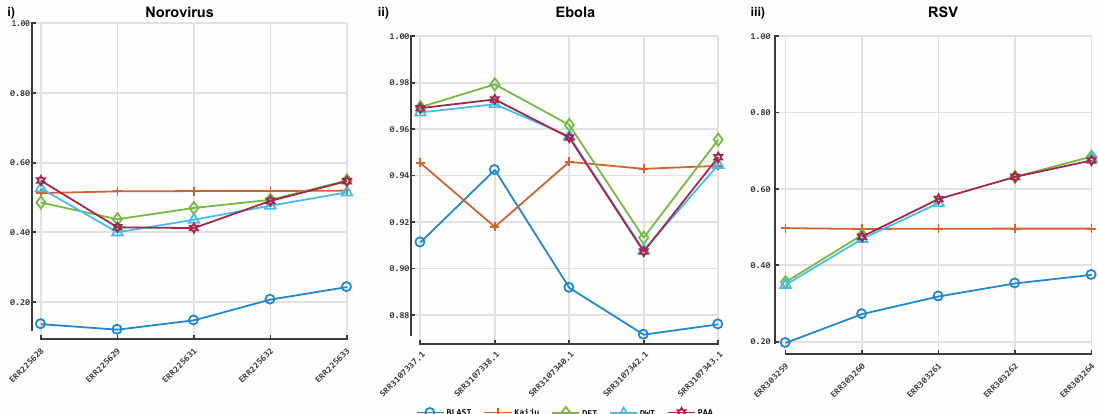
Figure 5. Accuracy of our prototype classification implementation and two established tools on real sequences. The y -axis indicates the F -measure score, and the x -axis depicts the reads data files. Plot 5-i depicts the F -measures obtained for each classifier on the Norovirus sequences data. Plot 5-ii illustrates the F -measures obtained for each classifier on the Ebola sequence data. Plot 5-iii illustrates the F -measures obtained for each tool on Respiratory syncytial virus (RSV) sequence data. DFT: discrete Fourier transform; DWT: discrete wavelet transform; PAA: piece-wise aggregate approximation.